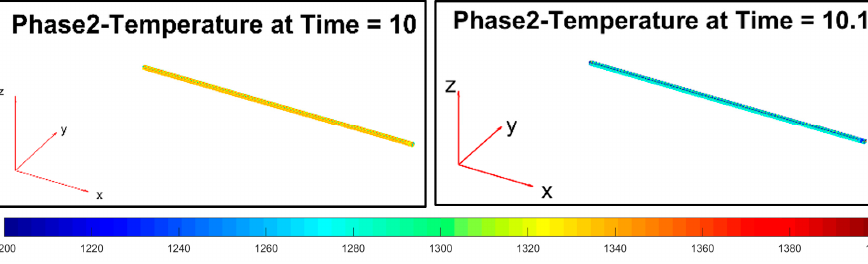
Figure 14. Modelization: phase 2 (descaler processing).